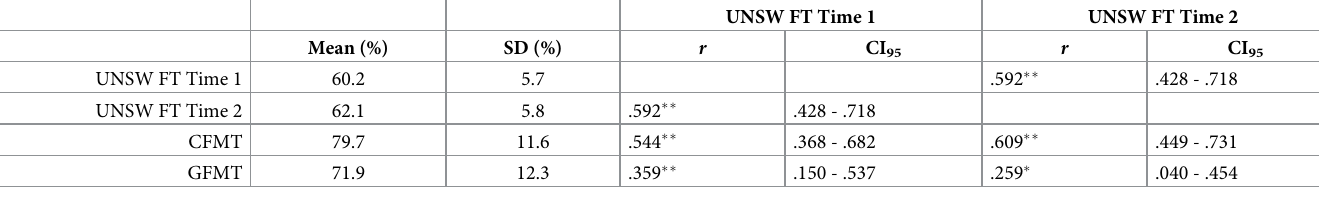
Table 2. Reliable correlations between the UNSW Face Test and the CFMT and GFMT for Lab Sample 1 demonstrate high convergent validity.